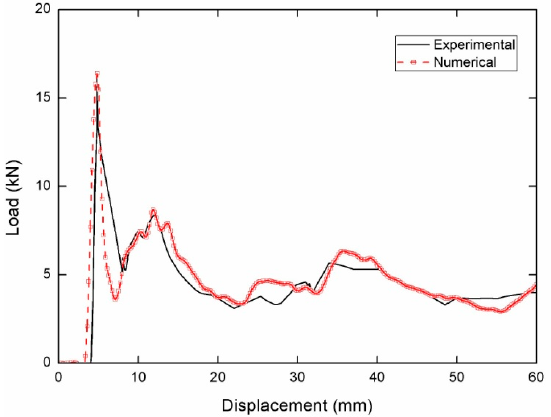
Figure 11. Comparison of force versus displacement curves between experimental and numerical results.